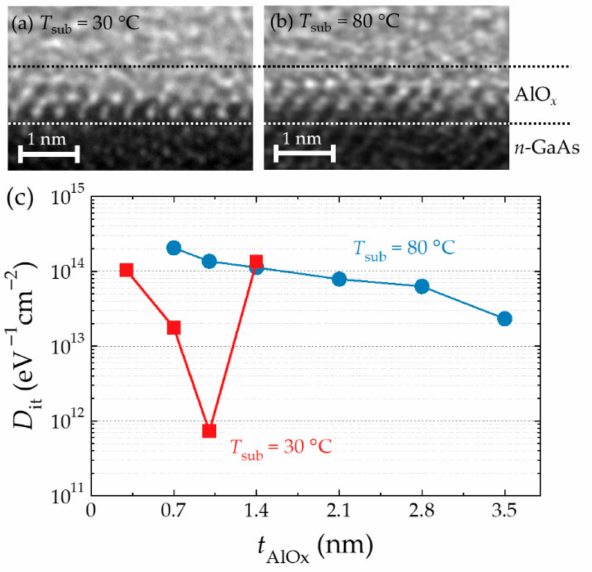
Figure 2. Cross-sectional TEM images of 1-nm-thick AlO x on n -GaAs with epitaxial Al layers grown at T sub of ( a ) 30 ◦ C and ( b ) 80 ◦ C. The horizontal dotted lines roughly indicate the boundaries. ( c ) Thickness dependence of D it for AlO x layers formed via post-oxidation of Al epilayer at T sub = 30 ◦ C (red) and 80 ◦ C